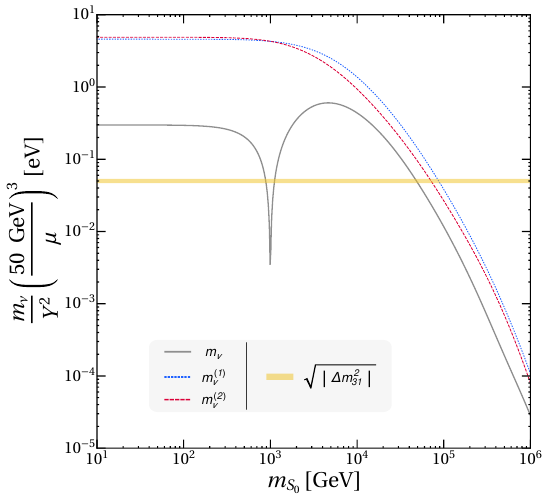
Figure 13 . Neutrino mass scale m (cid:23) (solid line) for the diagrams of (cid:12)gure 12 with respect to the mass of the neutral scalar S 0 . The rest of the masses are separated and represented as dashed lines. The atmospheric mass scale (yellow line) is plotted for comparison. See text for